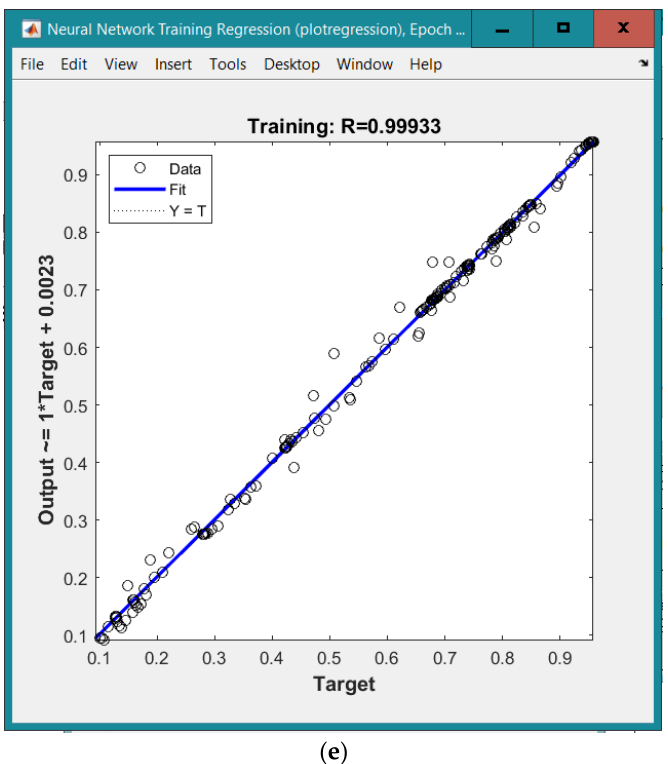
Figure 7. NNC training: ( a ) conditions; ( b ) training data; ( c ) training result; ( d ) performance; ( e ) regression.